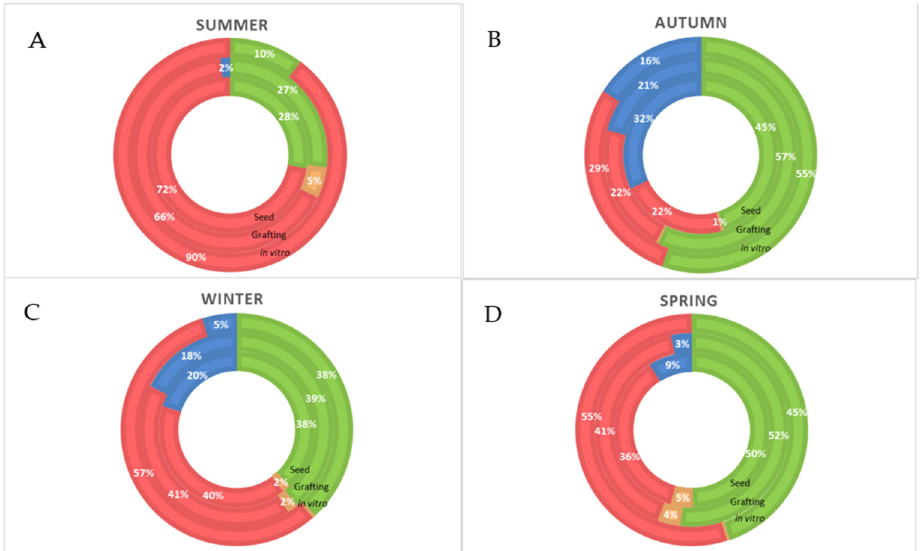
Figure 3. Seasonal frequency (%) of elongata hermaphrodite flowers (green); that later will produce fruits of commercial interest, non-elongate hermaphrodite flowers (orange), pentandric and carpeloid hermaphrodite flowers (red), and sterile; functionally male flowers (blue) found in ‘Alicia’ papaya propagated by seed, grafting and in vitro, and determined in ( A ) summer, ( B ) autumn, ( C ) winter